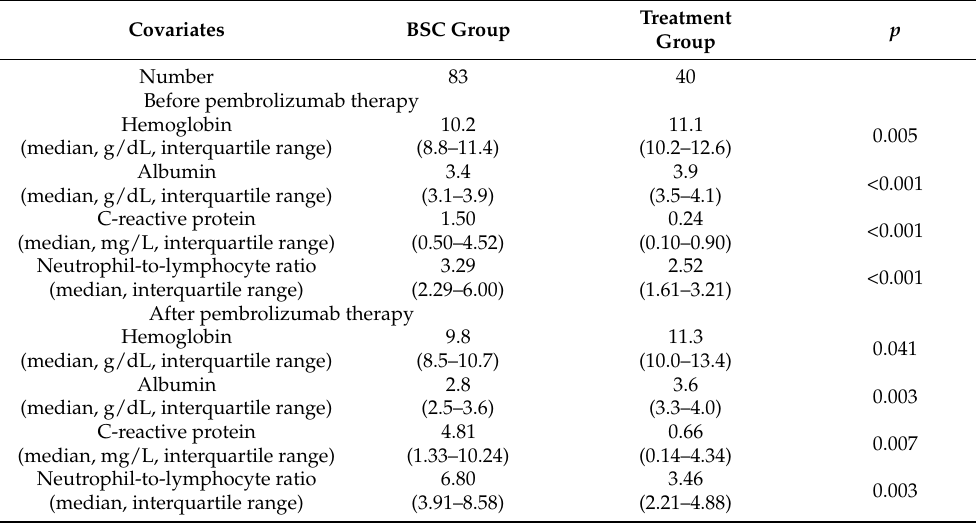
Table 2. Clinical covariates before and after pembrolizumab.